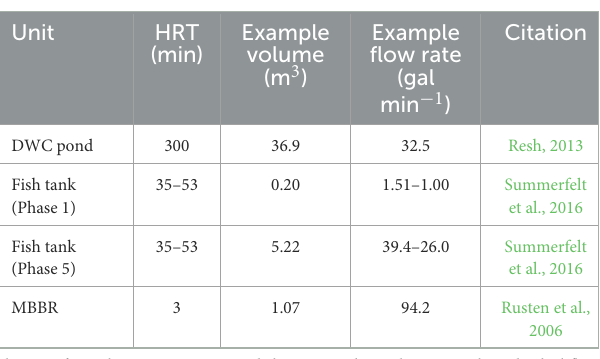
TABLE 5 Individual hydraulic management in a parallel unit process